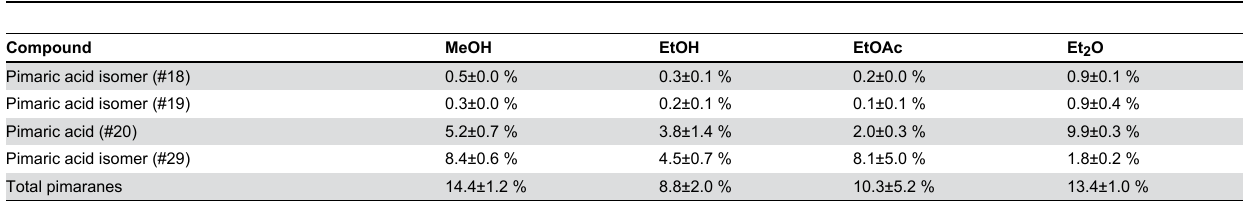
Table 1. Chemical composition of T. carbonaria propolis extracts in methanol (MeOH), 96% ethanol (EtOH); fractions in ethyl acetate (EtOAc) and diethyl ether (Et O). 2